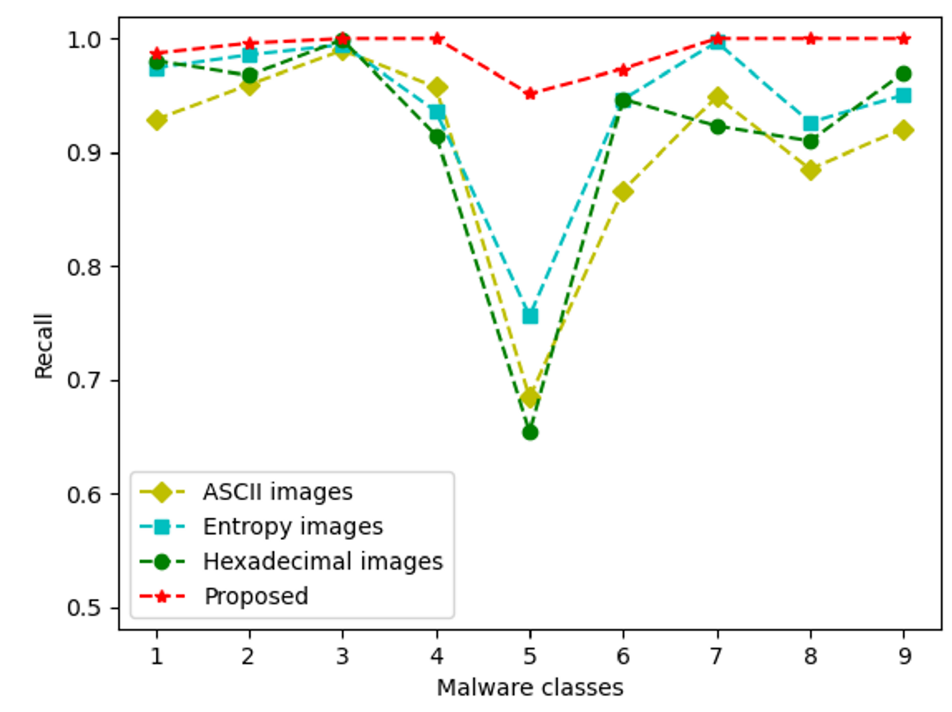
Figure 9. Recall of different grayscale images and multi-channel